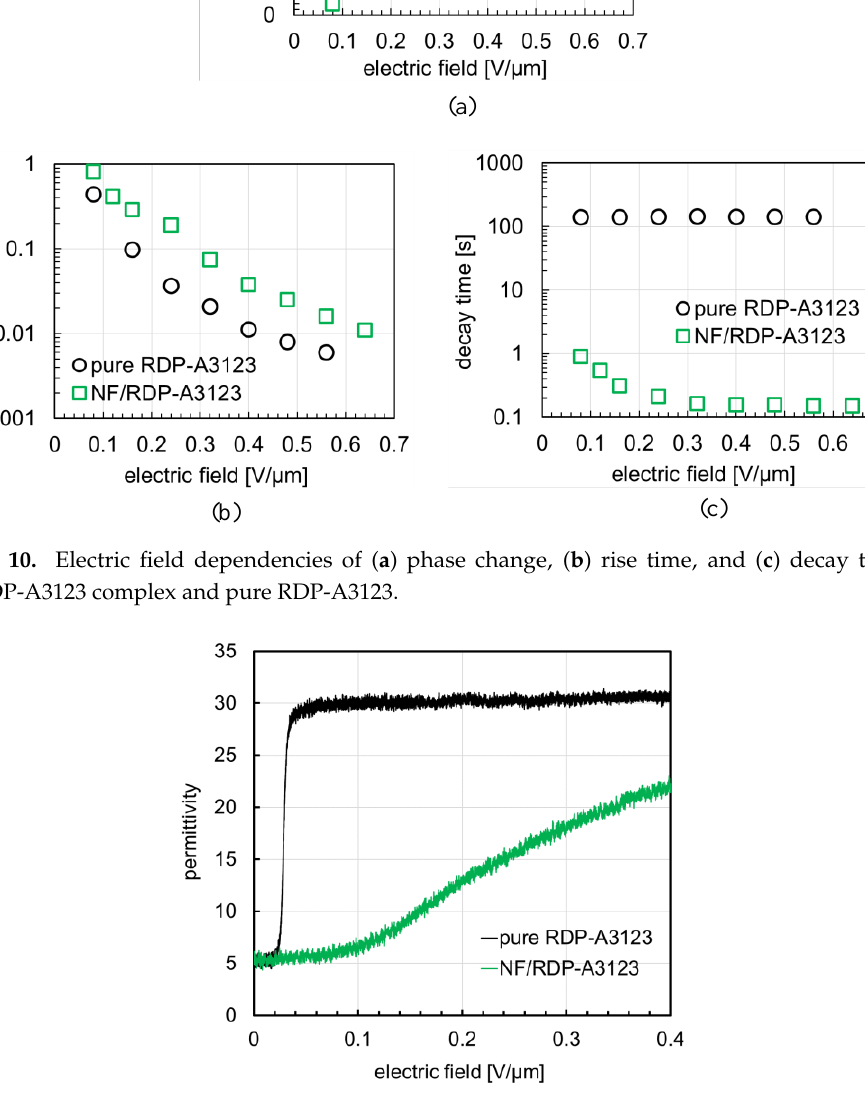
Figure 11. Comparison of permittivity between NF/RDP-A3123 complex and pure RDP-A3123.